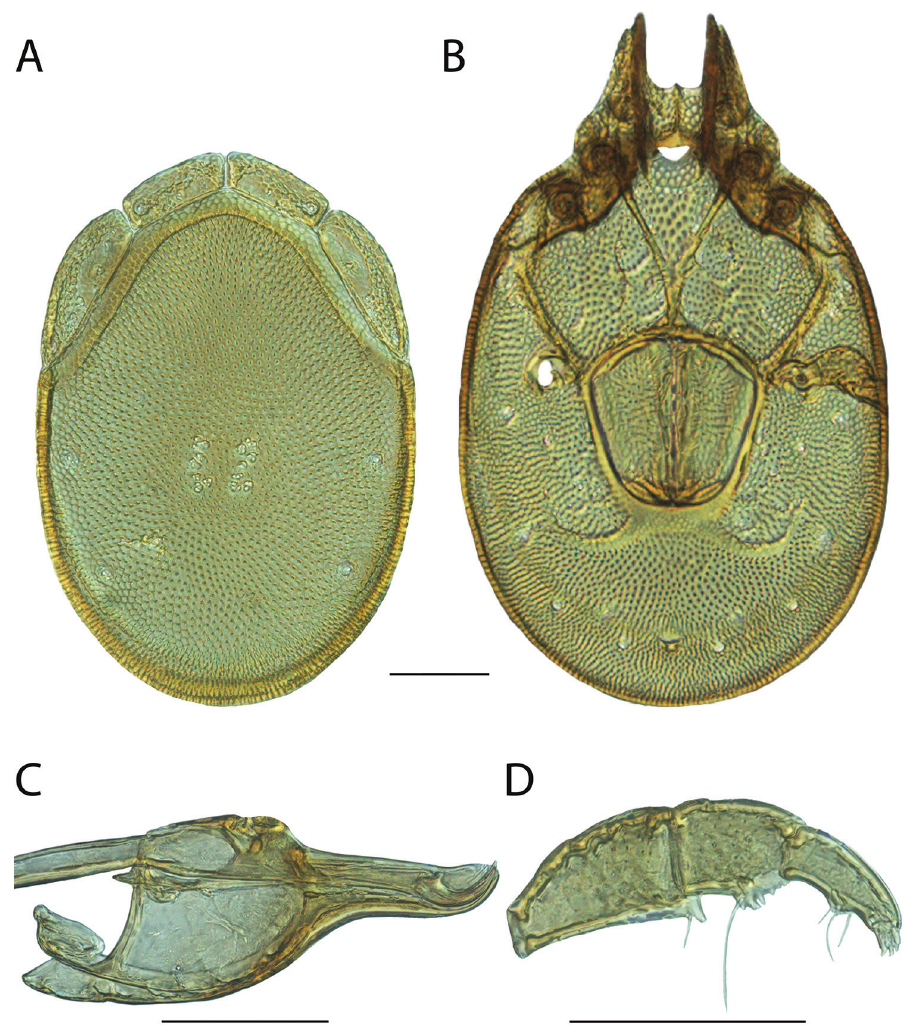
Figure 147. Torrenticola miniforma female: A dorsal plates B venter (legs removed) C subcapitulum D pedipalp (setae not accurately depicted). Scale = 100 µm. tarsus (15 long). Palpomere proportions: femur/genu 1.44; tibia/femur 0.64; tibia length/width 2.88. Venter — (680 long; 420 wide) colorless. Gnathosomal bay (145 long; 62.5 wide). Cxgl-4 subapical. Medial suture (50 long). Genital plates (167.5 long; 165